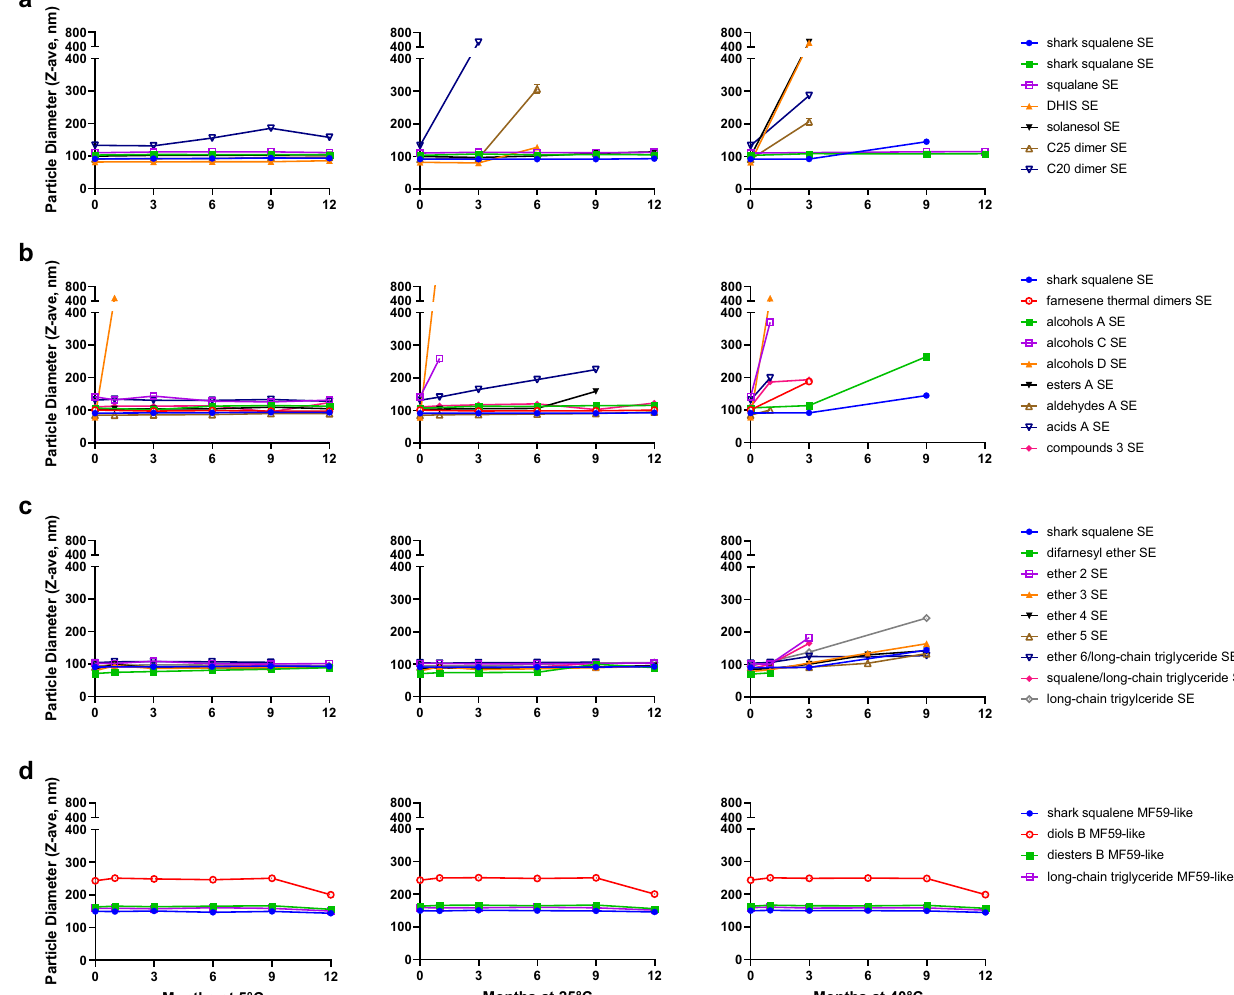
Fig. 1 Physical stability of oil-in-water emulsions. Emulsions were stored at 5 °C, 25 °C, or 40 °C for up to 12 months and monitored by dynamic light scattering to assess emulsion droplet diameter. Data are represented as means with error bars representing standard deviation of the measurement. a Linear terpenoid SE series, b cyclohexene terpenoid SE series, c ether terpenoid SE series, d MF59-like formulations of selected cyclohexene-containing